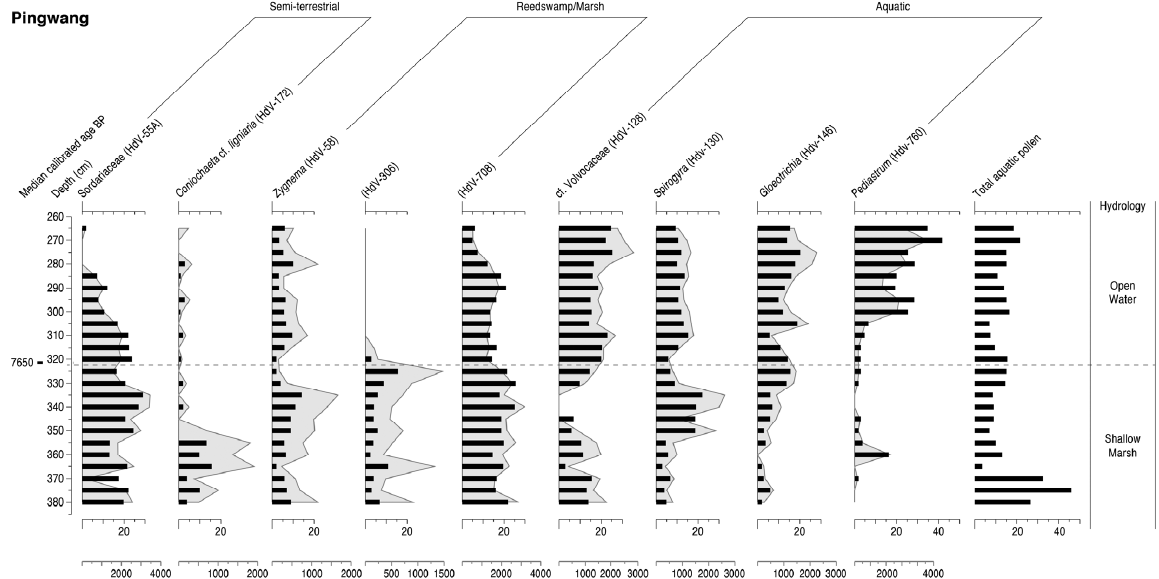
Figure 5. Frequencies of selected NPP taxa (histogram bars calculated as % total NPPs) from Pingwang. A combined aquatic pollen curve is also shown, calculated as percentages of total land pollen. Pollen concentration values for the NPPs are shown as shaded curves (numbers of grains per cc. on the secondary x-axis).